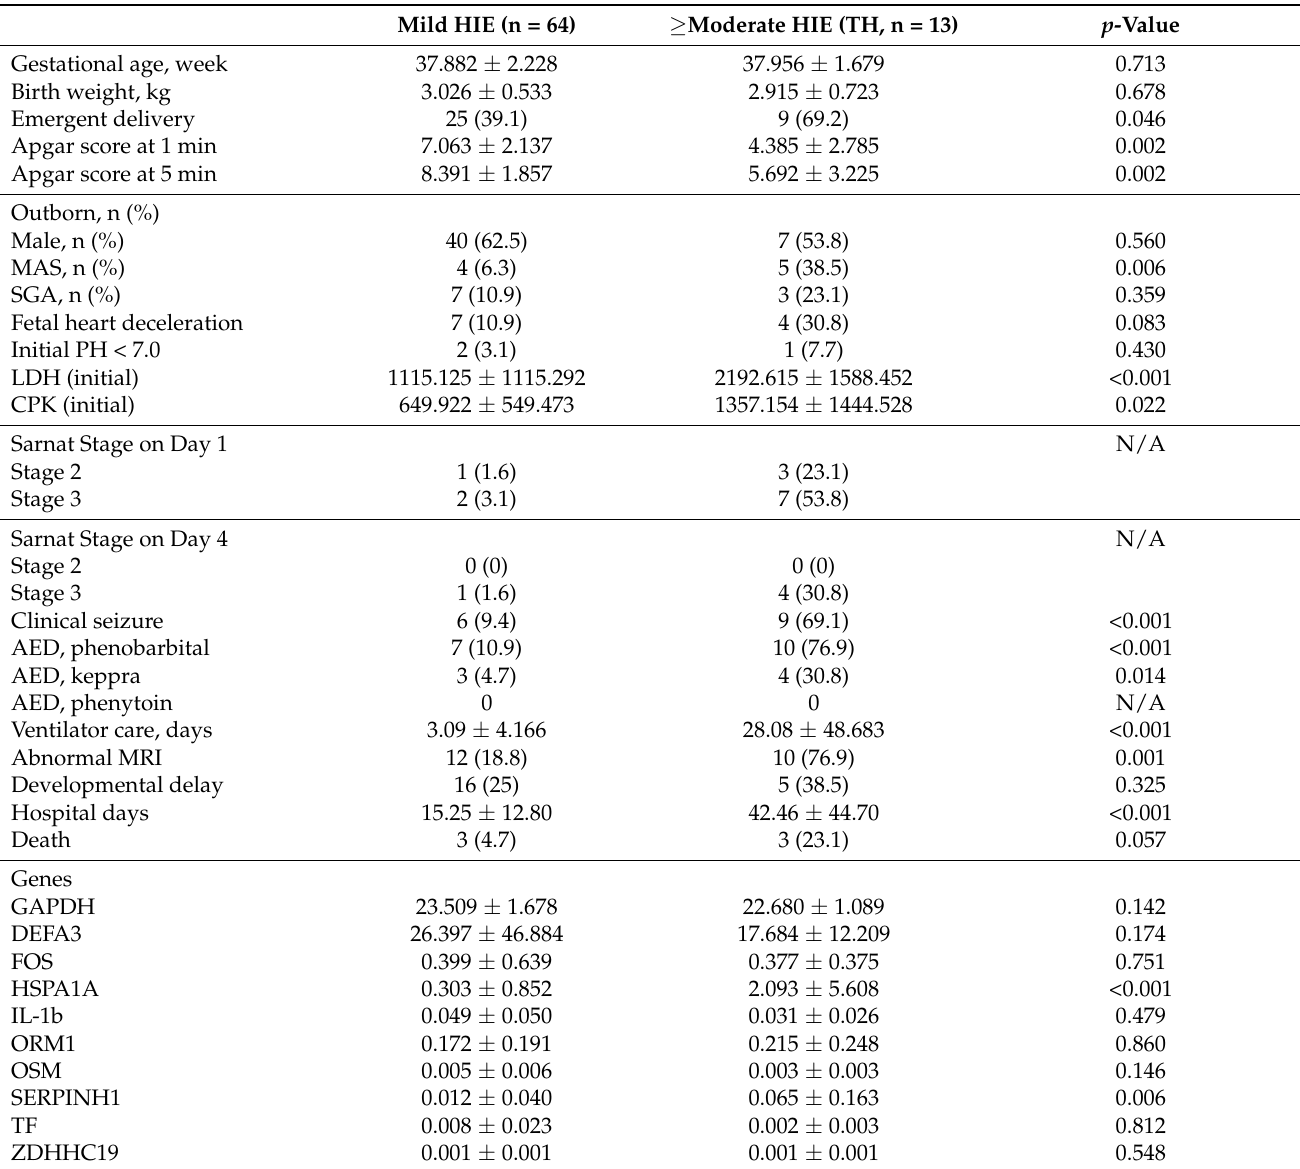
Table 1. Clinical characteristics of HIE infants (n =